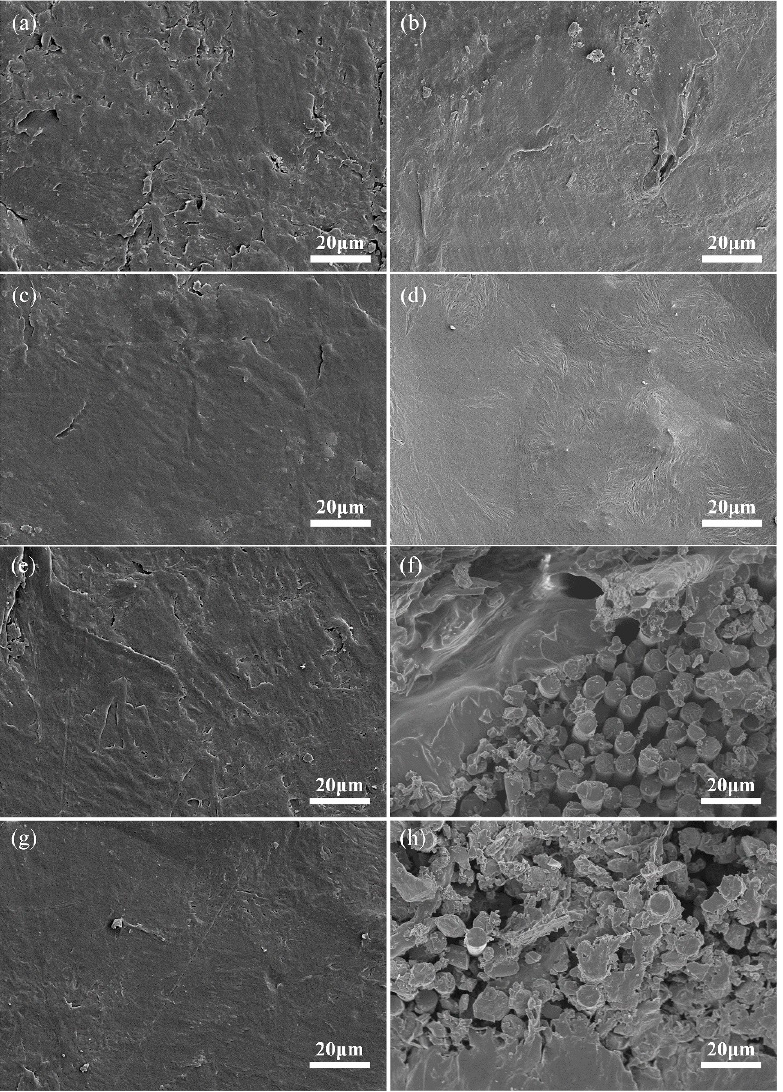
Figure 2. Surface and cross section micrographs of ( a , b ) SPU, ( c , d ) G/SPU, ( e , f ) CFF/SPU and ( g , h )